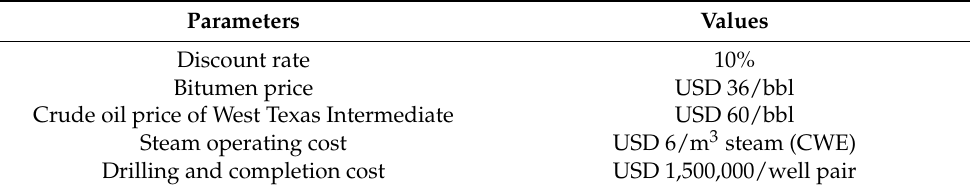
Table 4. The relevant parameters for the NPV